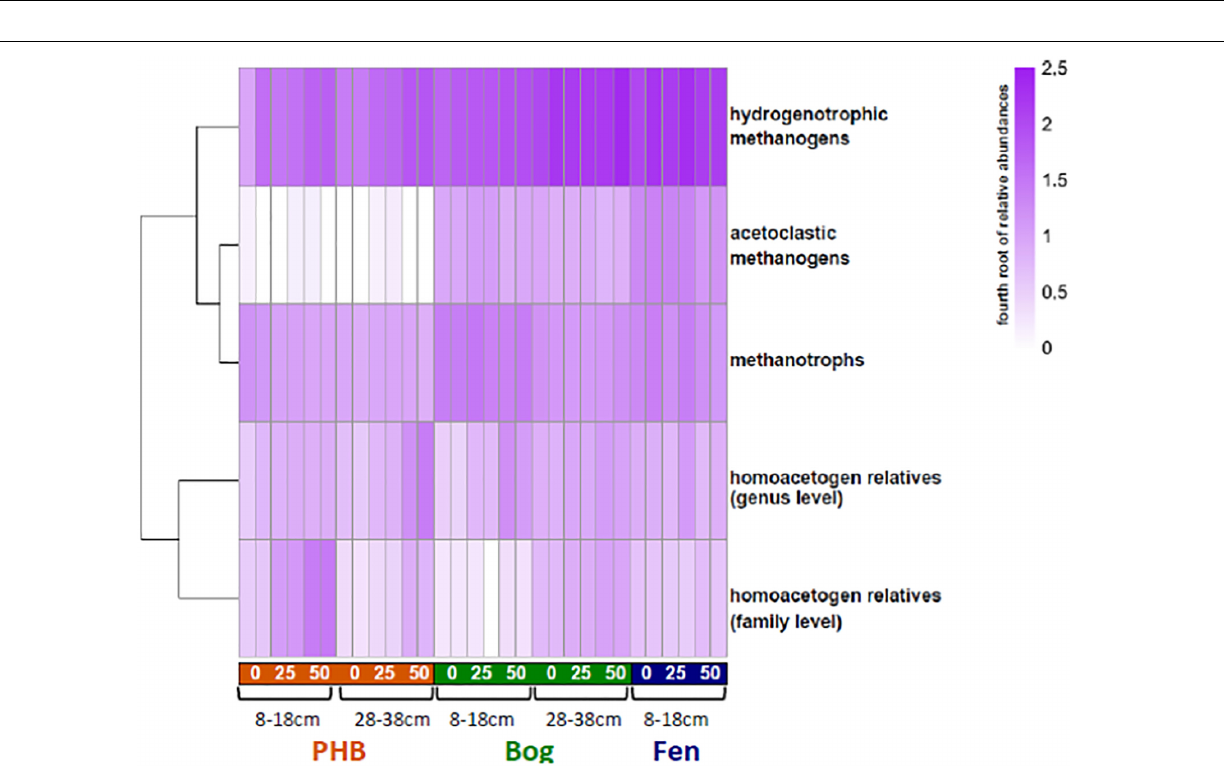
FIGURE 5 | Ratio of modeled rates of acetoclasty:hydrogenotrophic methanogenesis for each of the four model variants. Stars indicate medians and box heights outline interquartile ranges of posterior likelihoods. Box widths are staggered so that overlapping ranges can be visually distinguished. Blue symbols with dashed lines indicate the ratio of acetoclast to hydrogenotroph abundances in the incubations. In the collapsed palsa (28–38 cm) the hydrogenotrophy rate at days 25 and 30 was 0 µ mol month - 1 (i.e., acetoclasty:hydrogenotrophy was undefined) which prevented us from calculating ratios after day 20 for that incubation.